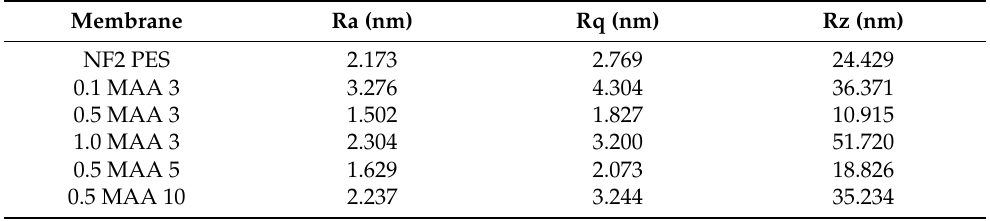
Table 3. Roughness parameters (Ra, Rq, Rz) of the surface of the unmodified and the UV − grafted membranes.